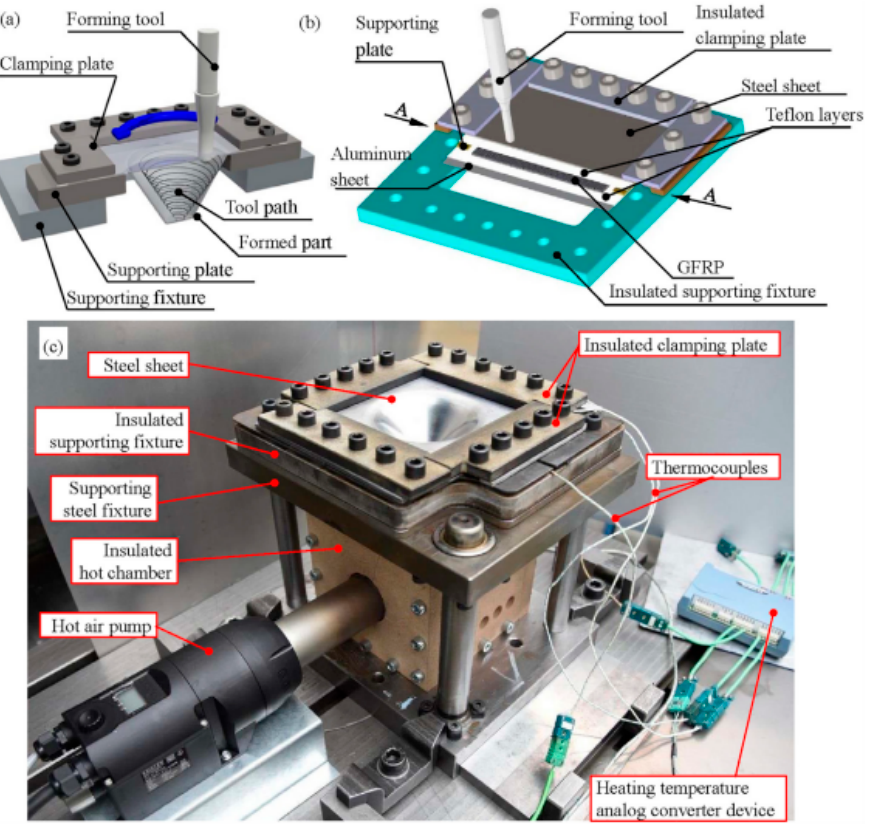
Figure 23. Principle of hot SPIF: ( a ) workpiece combination, ( b ) clamping fixture, and ( c ) setup assembly (reproduced with permission from [271]; copyright© 2021 The Society of Manufacturing Engineers. Published by Elsevier Ltd.).